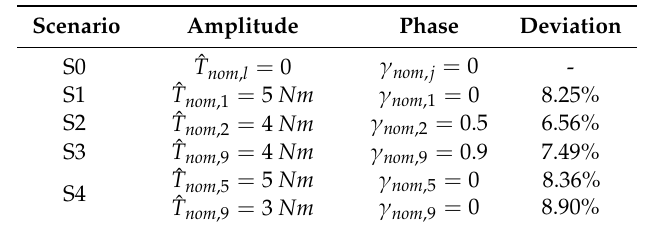
Table 4. Requirements of the scenarios used for validation, as well as the deviation of the generated harmonics from the required values. The index value of amplitude and phase indicates the number of the required harmonic